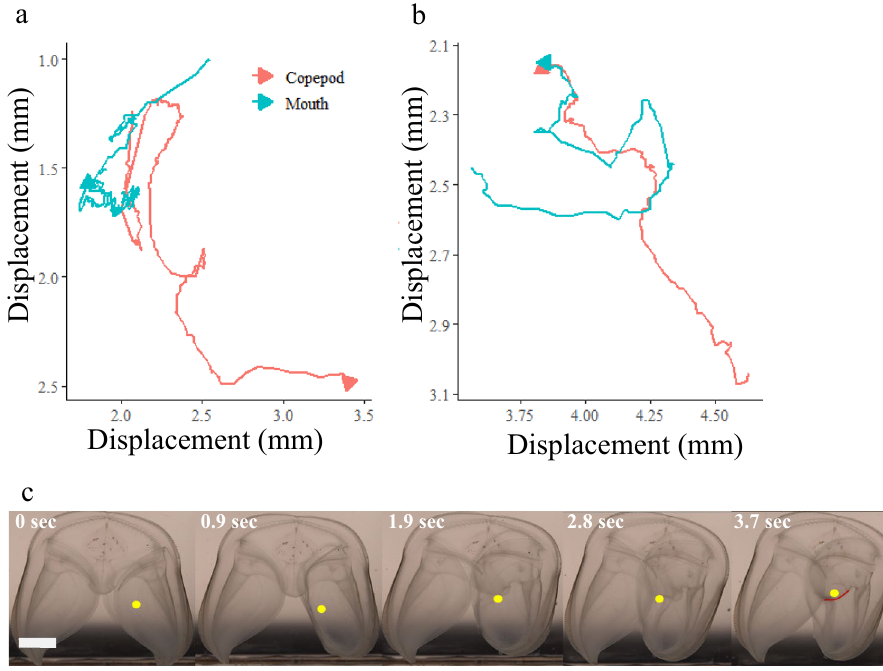
Figure 2. Example of 2-dimensional displacements of both copepod and ctenophore mouth for two predation attempts. Arrows indicate ending points. ( a ) copepod escape, encounter lasted 6.7 s, ( b ) copepod capture, encounter lasted 3.7 s. Axes have been adjusted to better display details of the encounter. ( c ) sequential images displaying the encounter in panel ( b ). Yellow dots show copepod location, red curve in the final photo outlines the edge of mouth to show that the copepod has been consumed. Scale bar in first image represents 5 mm.